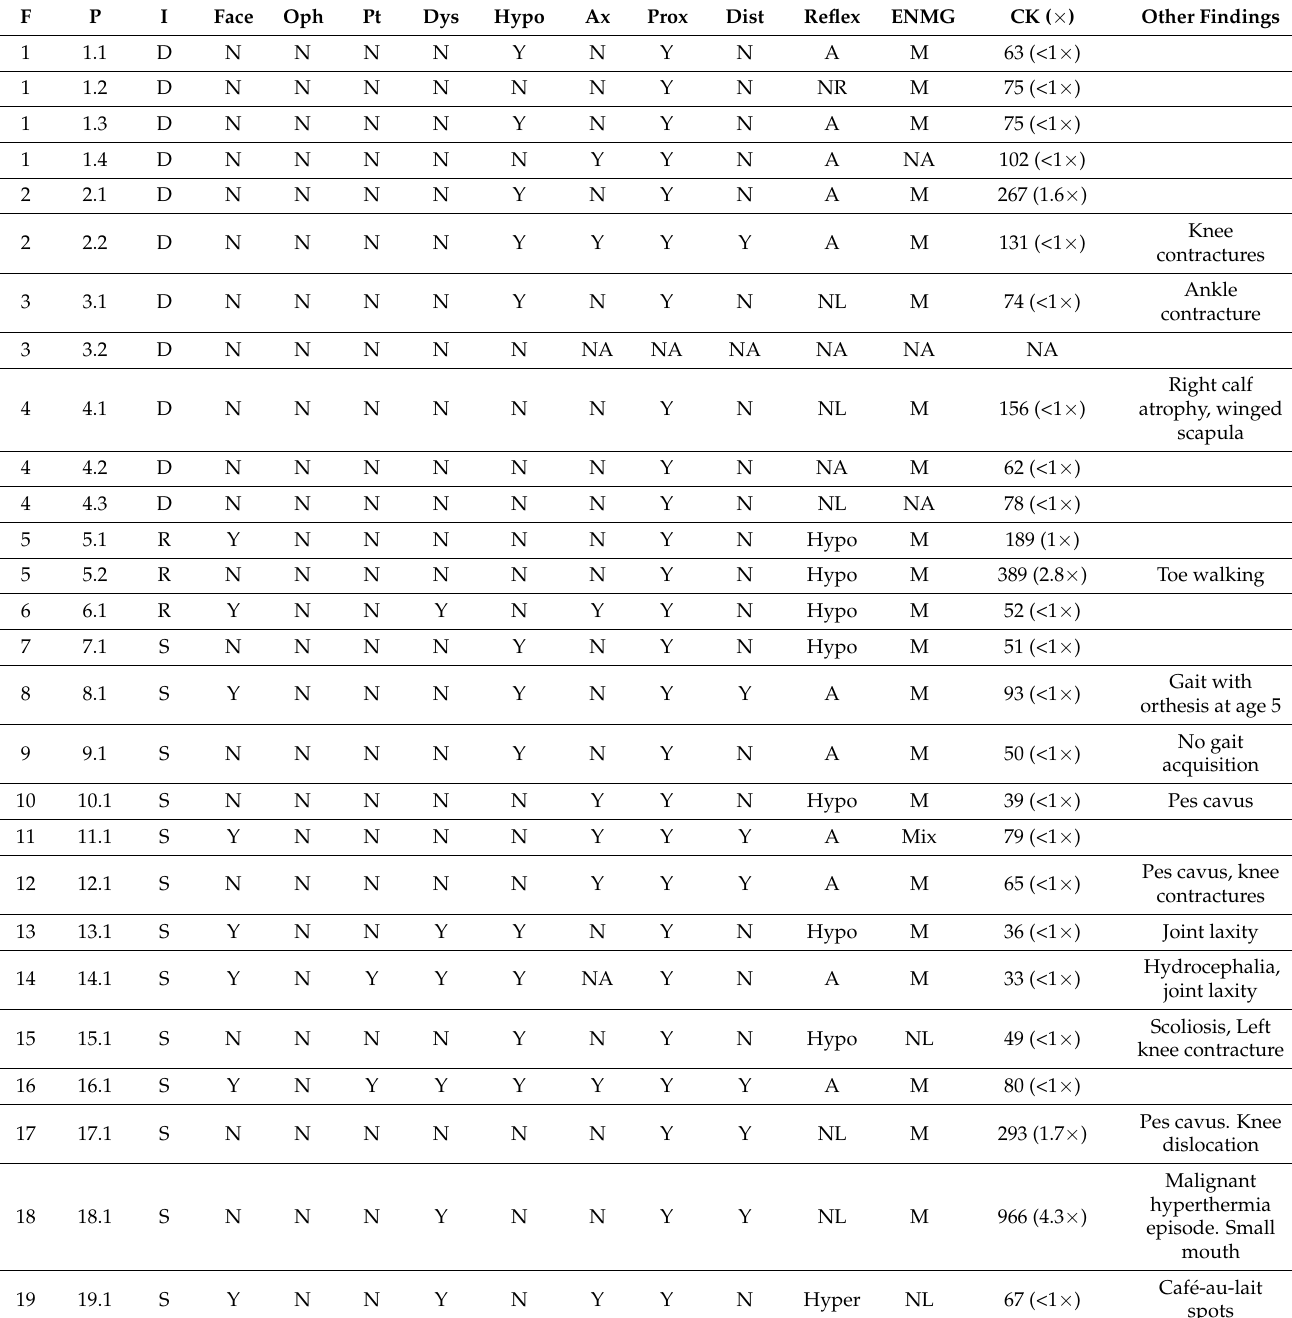
Table 2. Physical, neurophysiological, laboratorial findings in 27 Central Core Disease